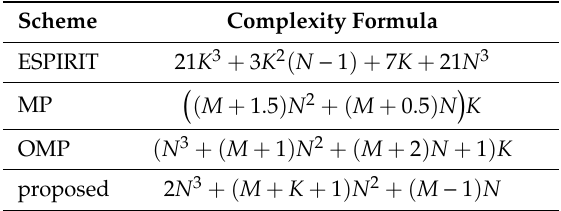
Table 1. Computing complexity analysis of di ff erent DoA estimation